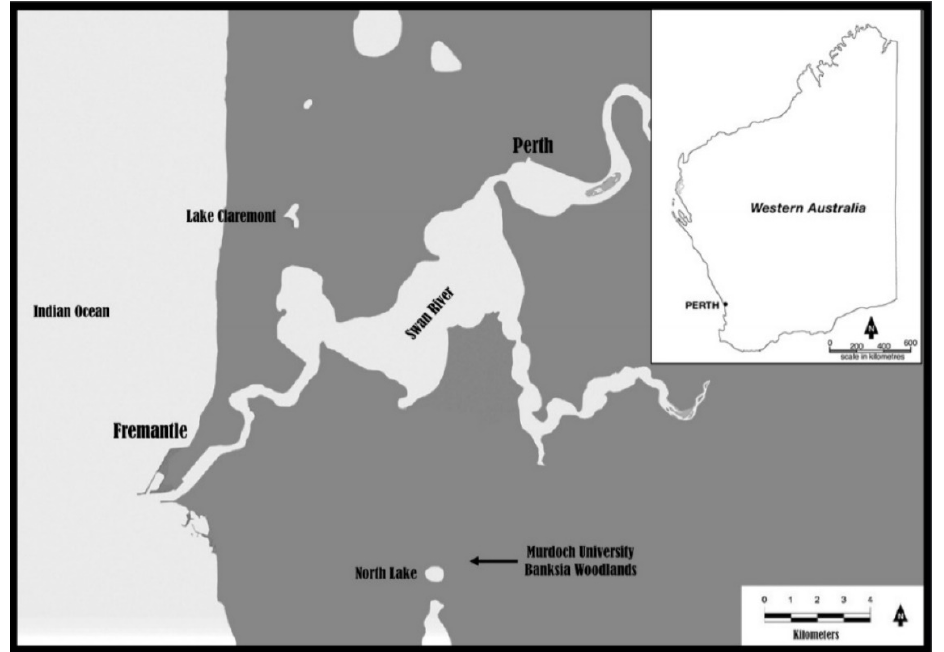
Figure 1. Location of study sites at Lake Claremont in the suburb of Claremont and Murdoch University in the suburb of Murdoch in relation to significant anthropogenic and geomorphic landscape elements within the urban fabric of Perth, Western Australia.